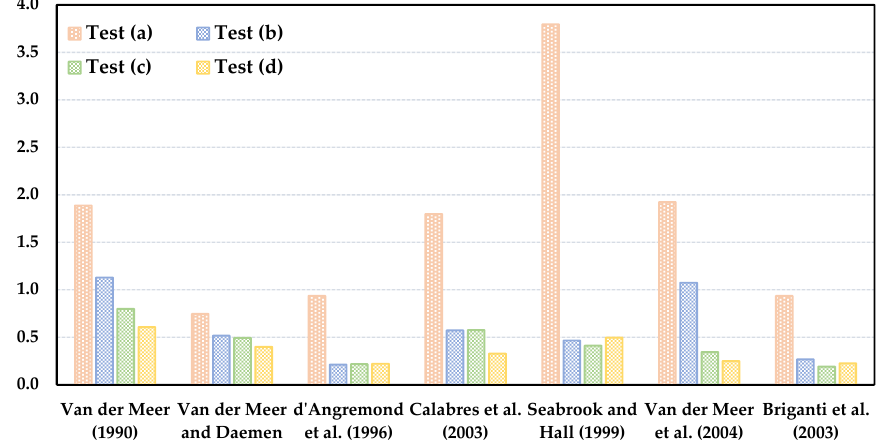
Figure 10. Root mean squared error, RMSE , for the analysed formulae.